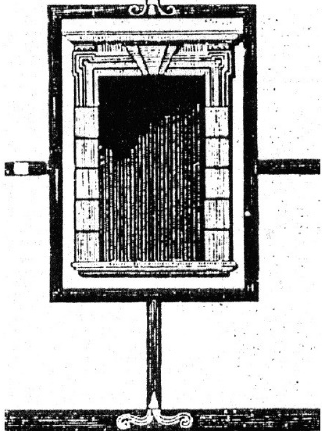
Figure 21. Inventory of a fragment of the sgraffito frame decoration on the walls of the castle in Świny. Source: H. Lutsch, Bildwerk, fol. 103.